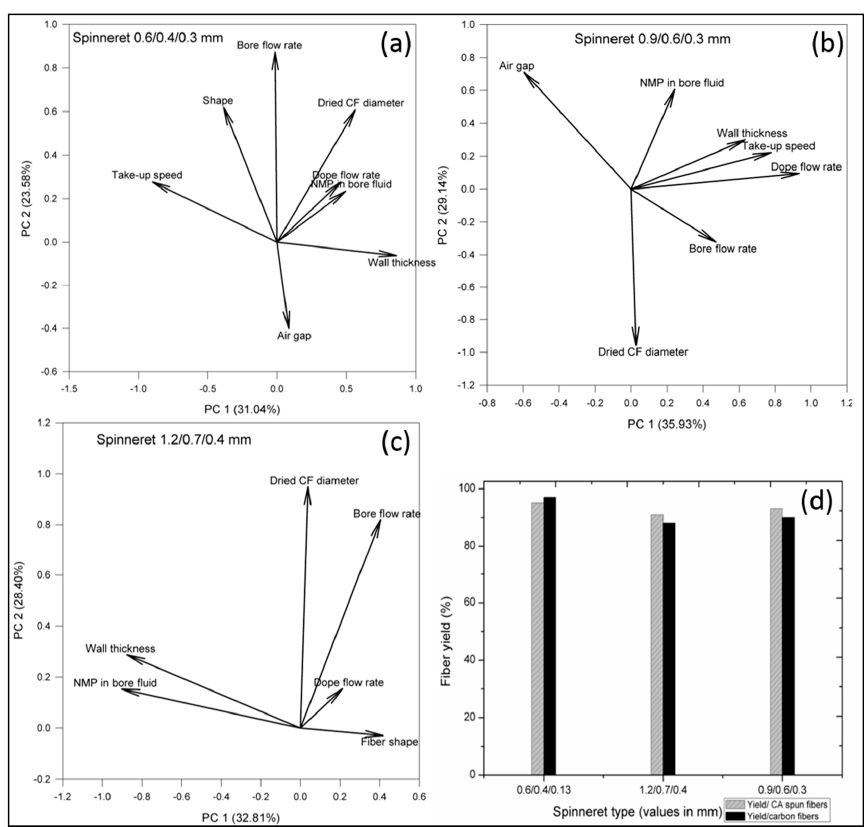
Figure A1. Principal component analysis (PCA) of three different types of spinnerets and resulting fiber yield.